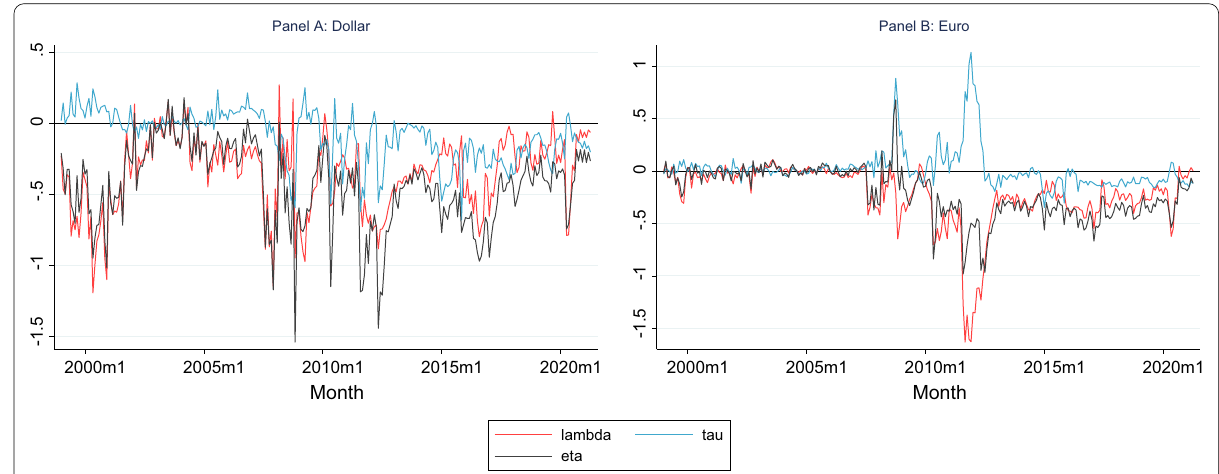
Fig. 7 Convenience Yield and Deviations from CIP. This figure shows the evolution of η (in black) and (cid:31) (in red), that are two measures of the convenience yields for the Swiss franc with respect to the euro and the US dollar at one‑year maturity. η is based on Eq. (4); (cid:31) involves the forward discount; the difference between the two ( τ , in blue) captures CIP deviations. Data source: Du et al. (2018) and Datastream. One unit corresponds to